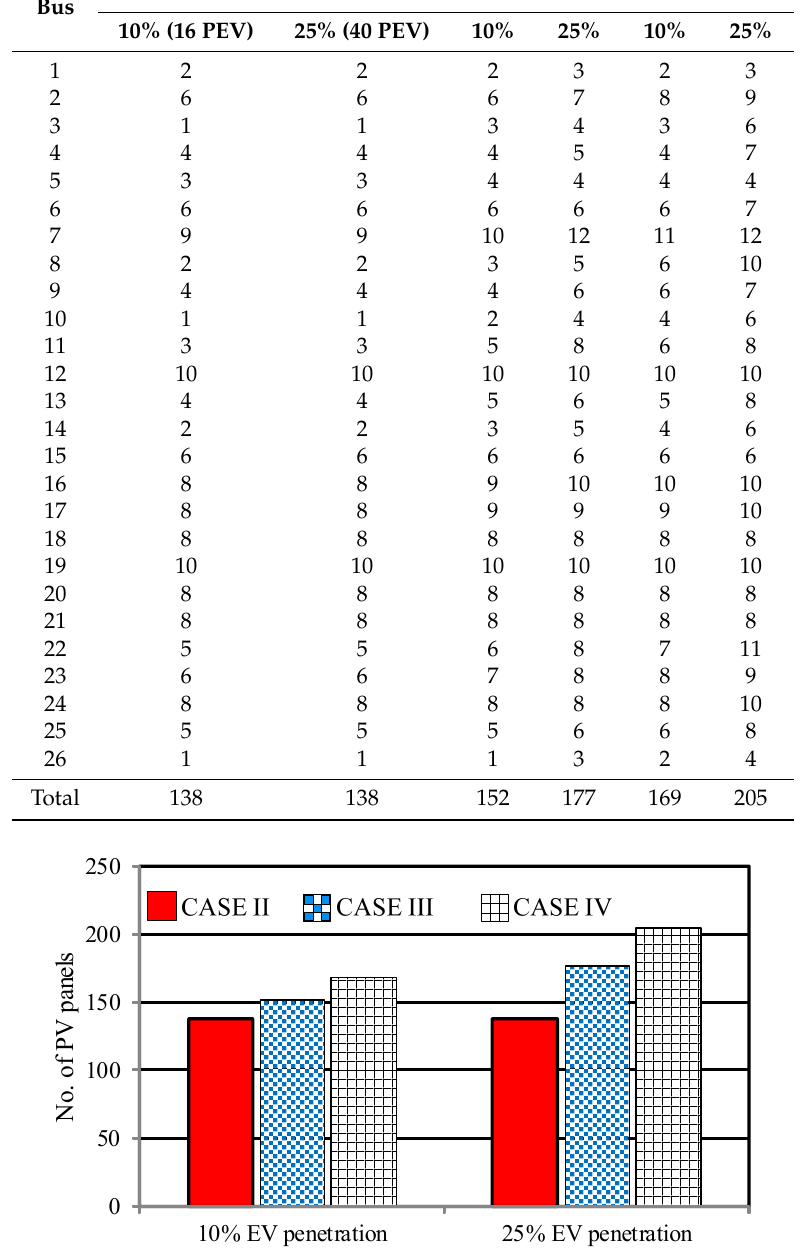
Table 2. Number of PV panels for cases II–IV considering two PEV penetration levels: 10% and 25% PEV penetration.